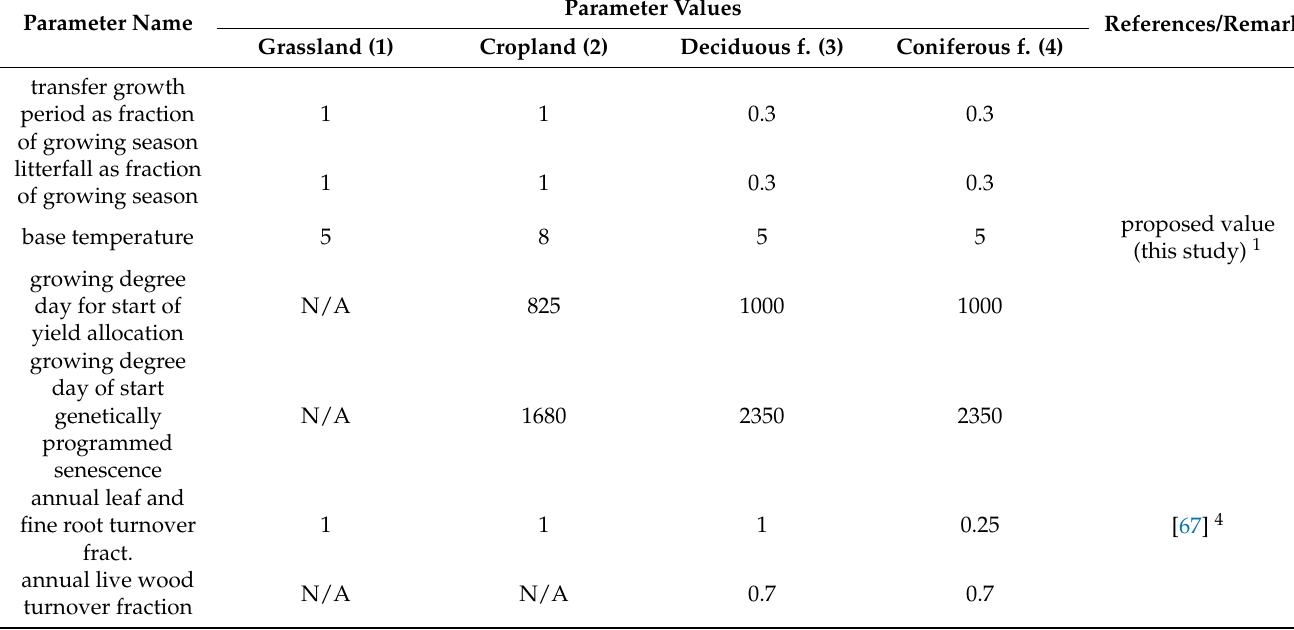
Table A1. List of ecophysiological parameters for the Biome-BGCMuSo v4.0 model used in this study. Values for Grassland, Cropland and Deciduous forest are from Hidy et al. (2016) [34], with some parameters adjusted according to specified references or proposed for the purpose of this study. Parameters for Coniferous forests are based on parameters for Deciduous forests and adjusted according to specified references. Superscripts in the Reference column refer to the vegetation type ( 1 Grassland, 2 Cropland, 3 Deciduous forest, 4 Coniferous